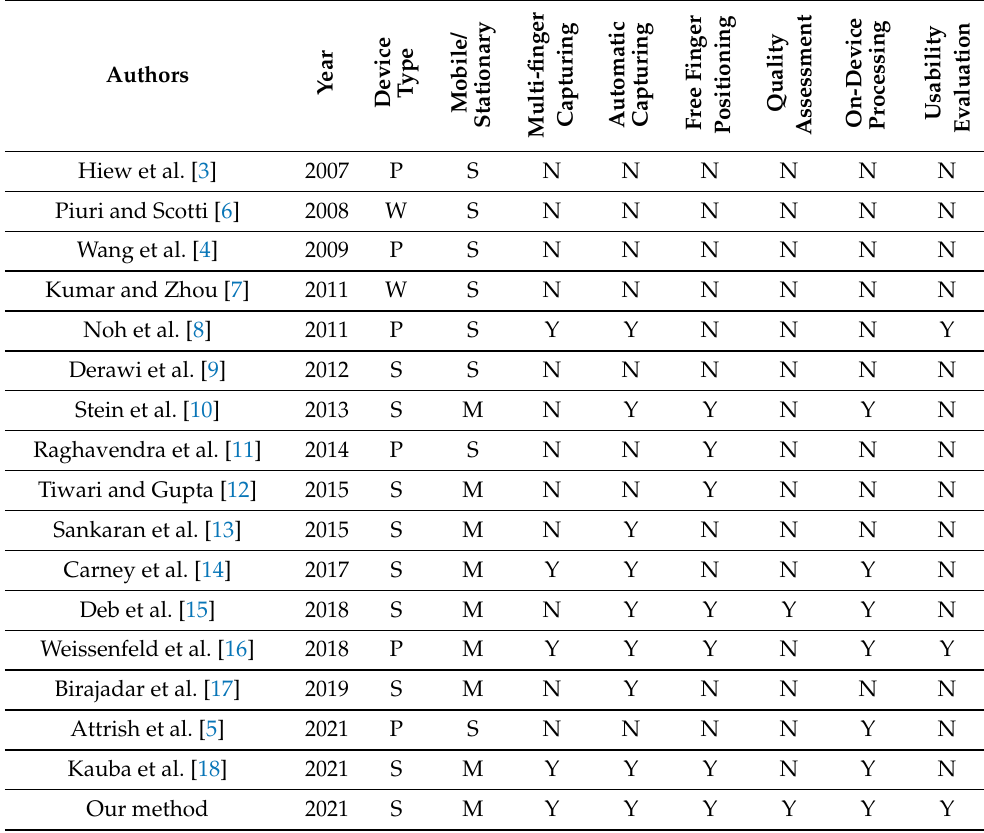
Table 1. Overview of selected recognition workflows with implementation aspects. (Device type: P = prototypical hardware, S = smartphone, W =